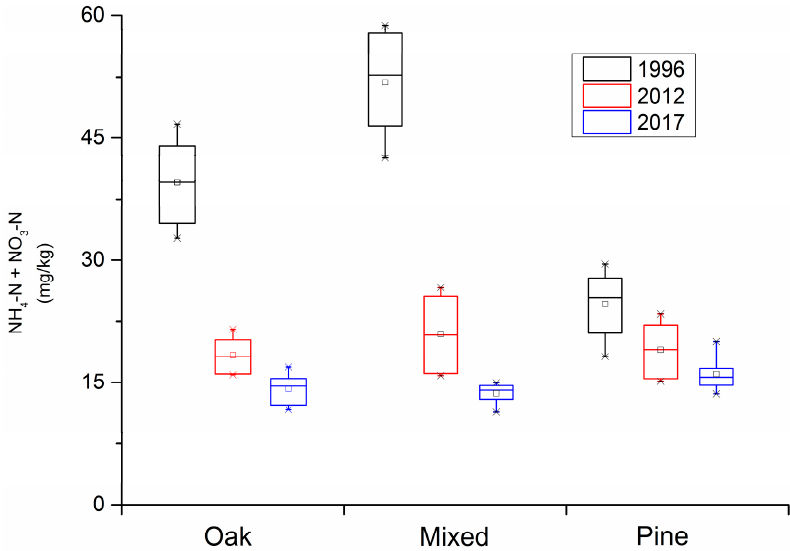
Figure 1. The loss in soil available nitrogen (N) along a 20-year time scale in the Qinling Mountains forest ecosystem. “AN” represents the soil available N at a given time, “Pinus” represents the P. armandii forest, “Mingled” represents the mixed Q . var. acuteserrata and P. armandii forest, and “Quercus” represents the Q . var. acuteserrata forest .